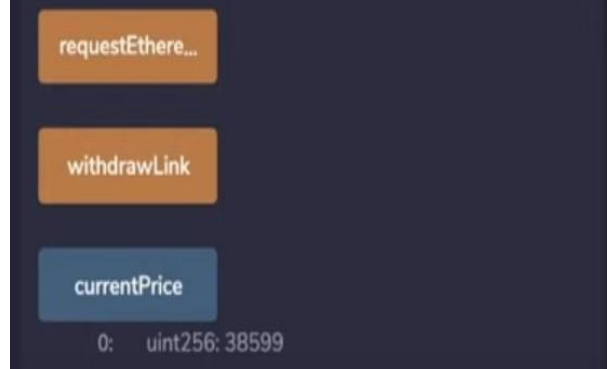
Fig. 5. Request for Ethereum price function